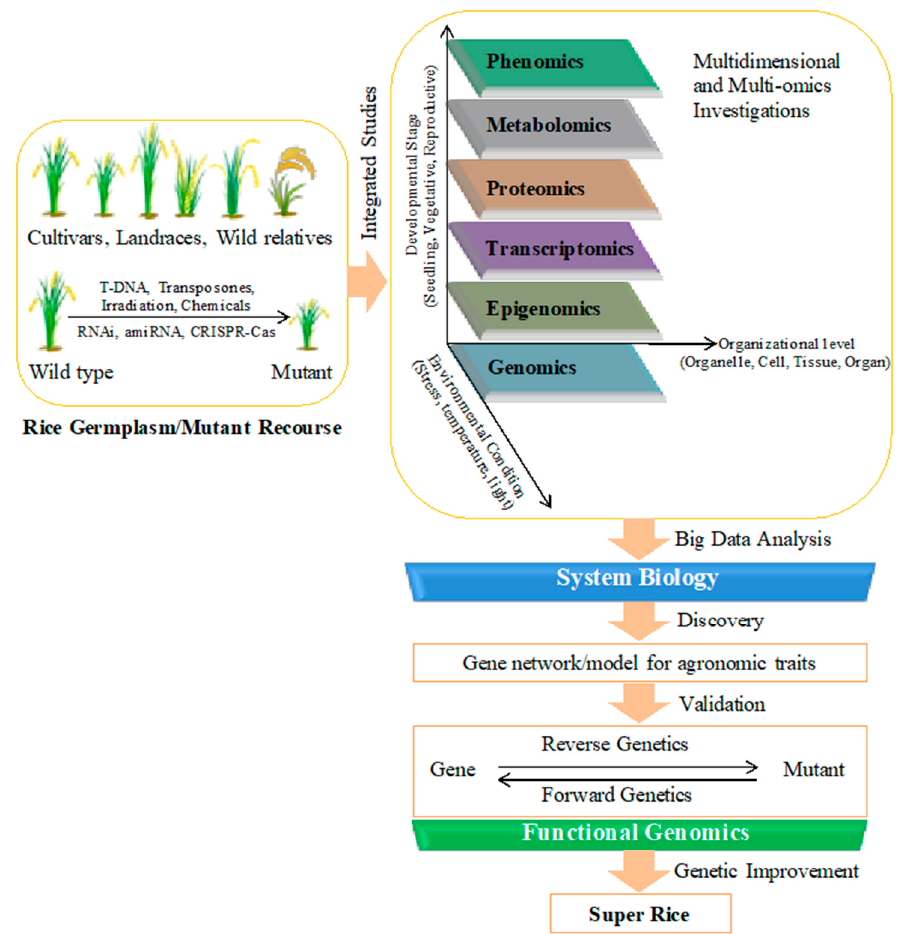
Figure 3. Systematic research approach involving integrated studies to develop super rice. Mutants lines generated through different mutagenesis techniques enrich the available rice resources along with the naturally occurring diversity of rice germplasm. Comprehensive analysis of available recourses using multi-omics and system biology approaches is needed for the discovery of genes governing important agronomic traits. Forward / reverse genetics are required for their functional validation